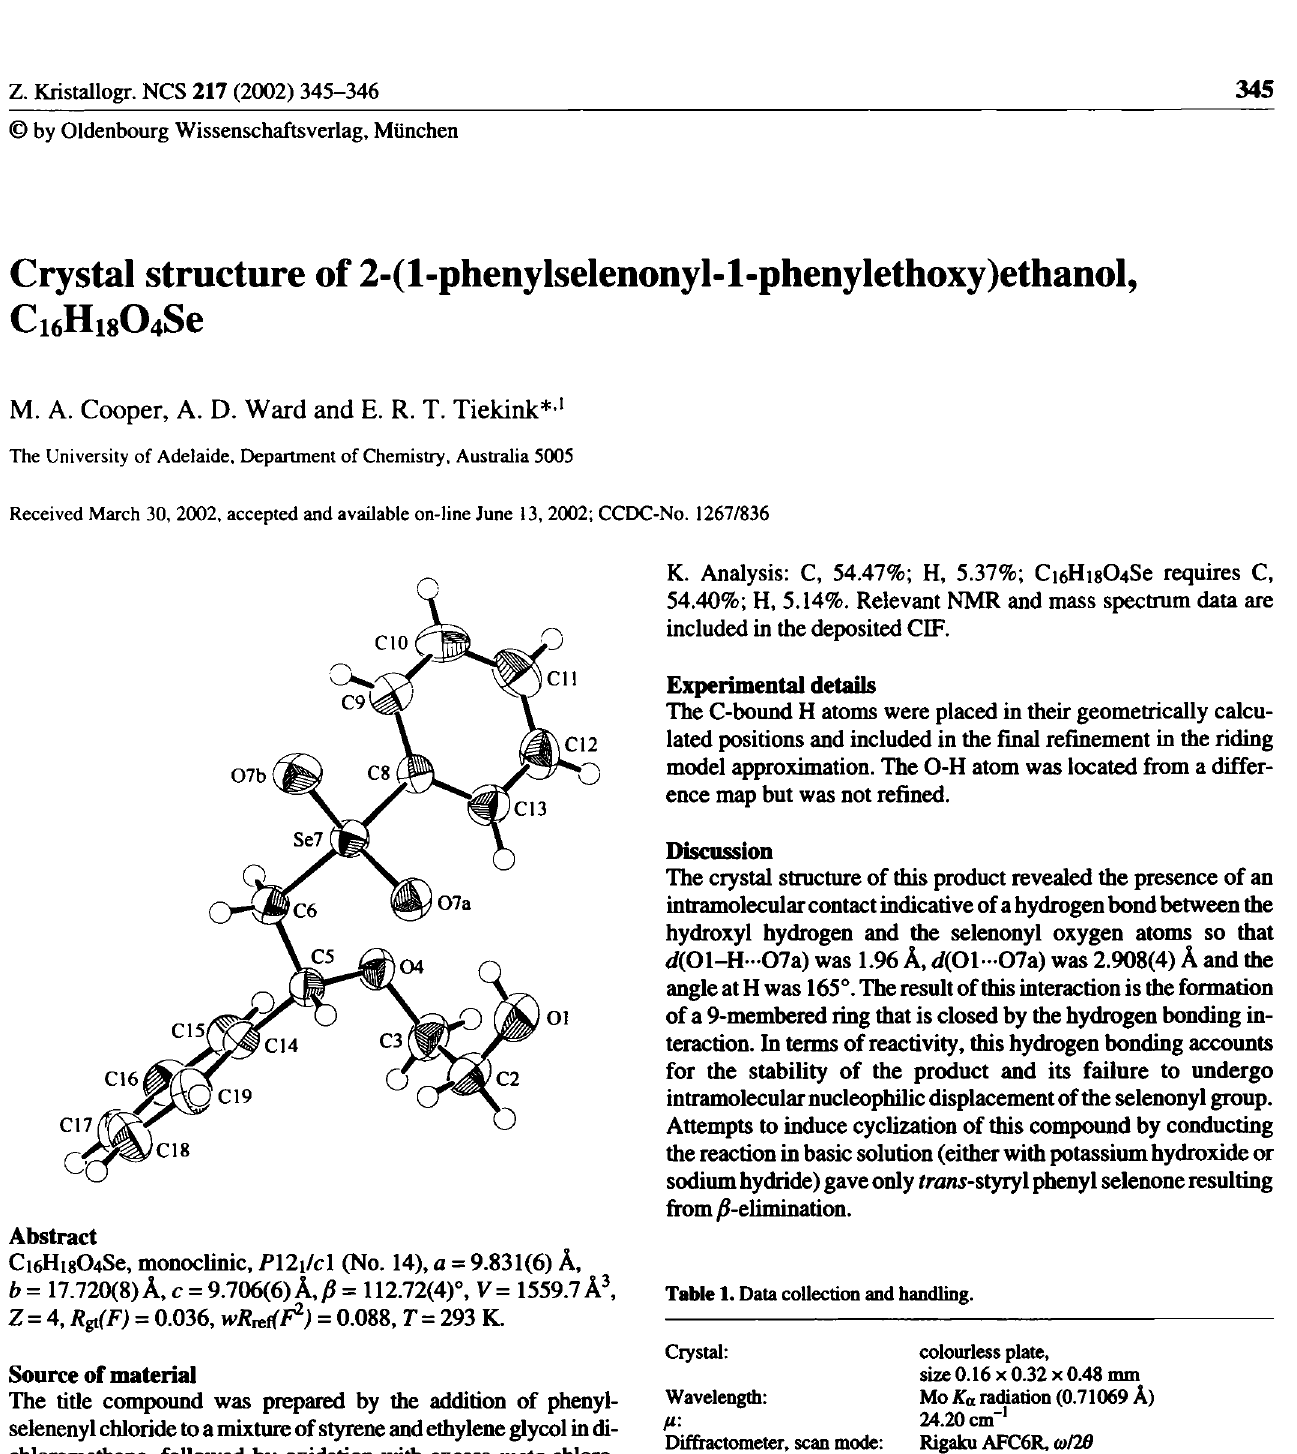
Table 1. Data collection and